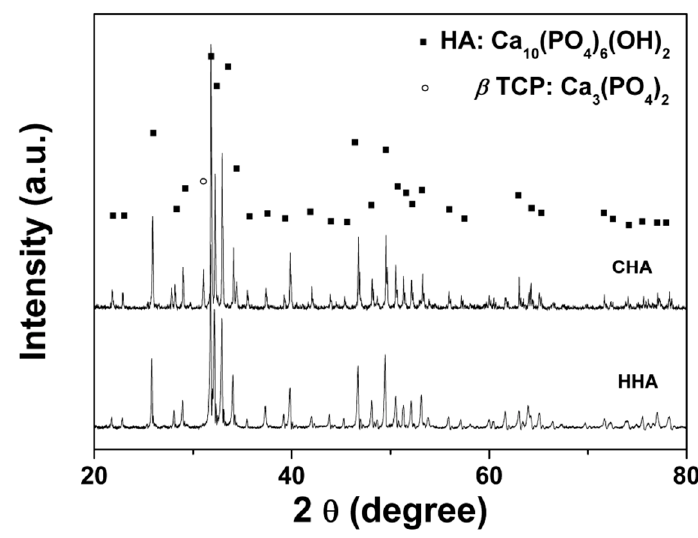
Figure 4. XRD patterns of the HHA sca ff old calcined at 720 ◦ C and CHA sca ff old calcined at 1100 ◦ C. Table 1. Compressive strengths of the CHA and HHA sca ff olds as-synthesized, and for HHA after degradation in PBS for 1–14